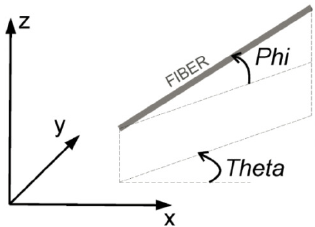
Fig. 10. Definition of Phi and Theta angles